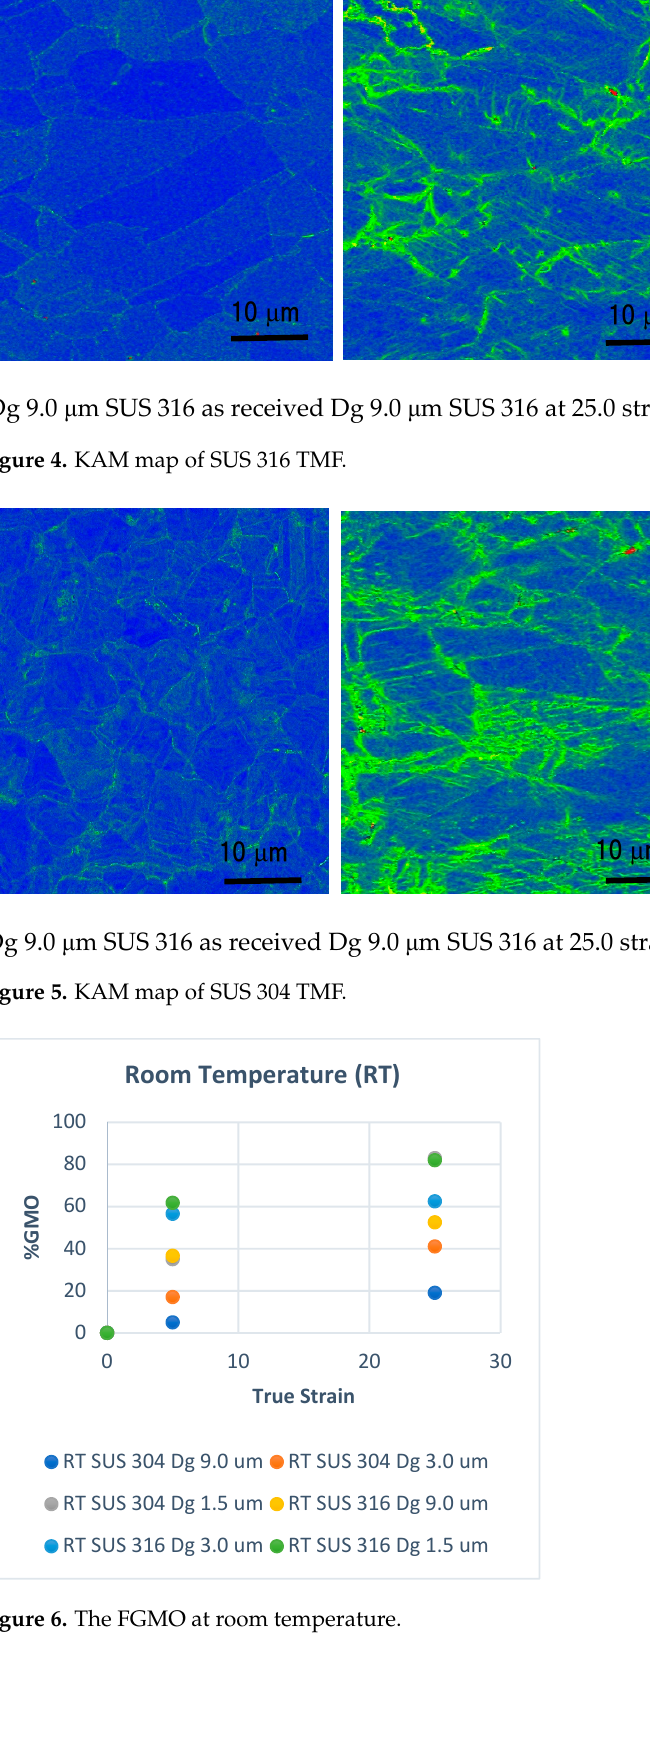
Figure 7. The FGMO with resistance heating (RH). The grain misorientation (GMO) is obtained from the calculation of the grain misori- entation in the center of the grains and then averaged, which can be obtained from the KAM map of the SEM-EBSD analysis of the structures after deformation [20]. In this study, the volume fraction of GMO means the amount of GMO in a certain area. Figures 4 and 5 show a typical KAM map for SUS304 and SU316 TMFs in coarse grains from the KAM map of SEM-EBSD analysis in a previous study [20]. The FGMO counted for SUS 304 and SUS 316 TMF at room temperature and RH con- ditions shown in Figures 4 and 5. The F GMO decreases with the grain size (Dg) and increases higher in SUS 316 compared to the SUS 304 TMF both in fine and coarse grains [20]. The GMO spread more inhomogeneously for the coarse grains of SUS 316 than the SUS 304 TMF. However, the surface roughness in SUS 304 coarse grains was higher than in SUS 316 TMF coarse grains since MPT only occurred at the same strain level in SUS 304 TMF. The higher surface roughness in SUS 304 could be affected by the MPT that spreads inho- mogeneously in the grains at room temperature.